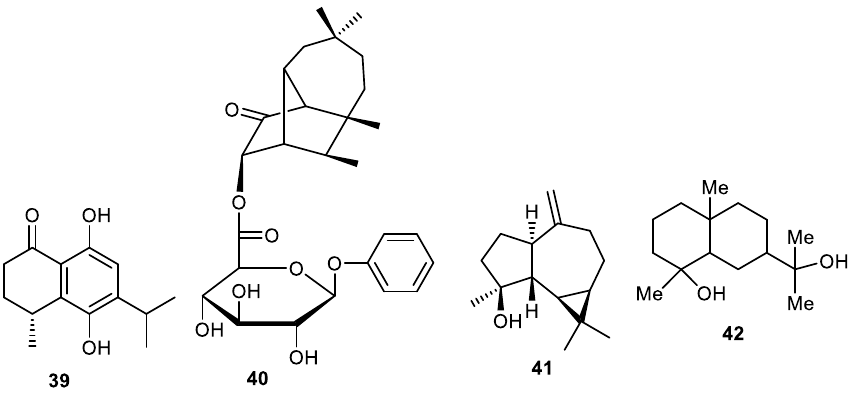
Figure 5. Structures of sesquiterpenes 39 – 42